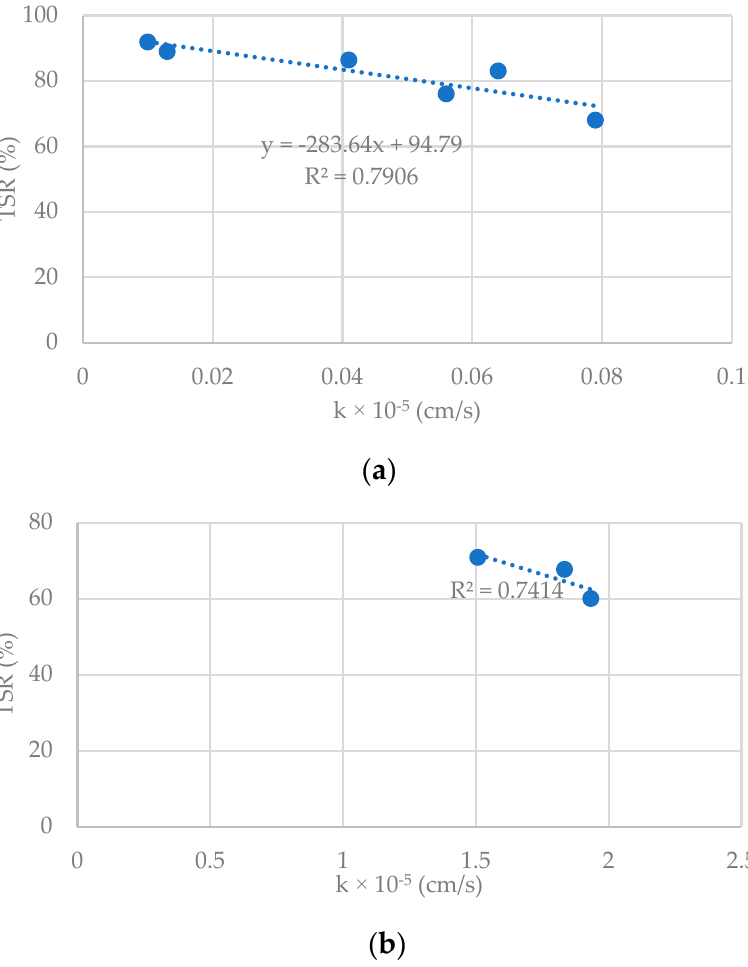
Figure 9. Relationship between TSR and coefficient of permeability: ( a ) dense gradation; ( b ) porous gradation. Table 6. IPAS analysis of